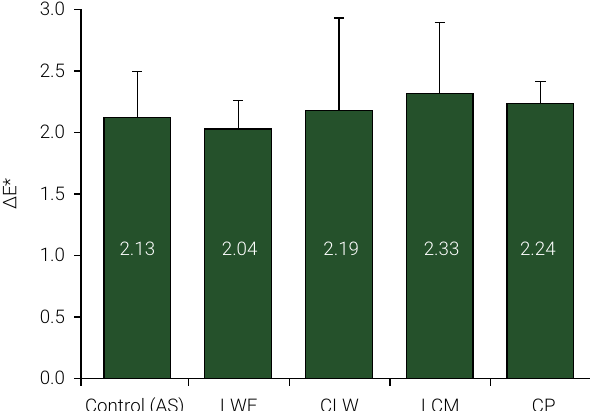
Figure 1. Water sorption and solubility of the nanocomposite Filtek Z350 after application protocol in whitening and conventional mouth rinses